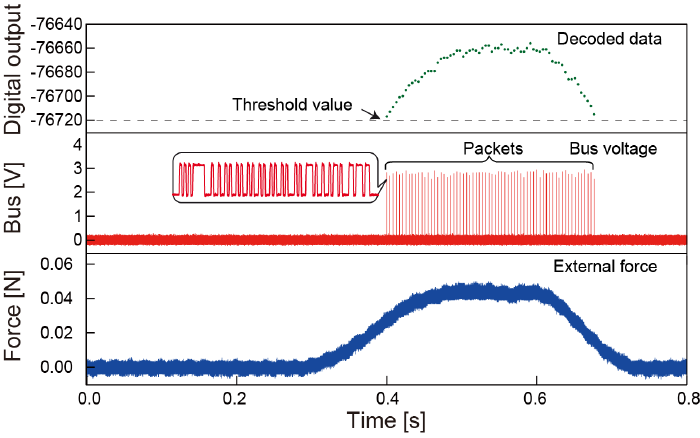
Figure 9. Response to an external force with threshold